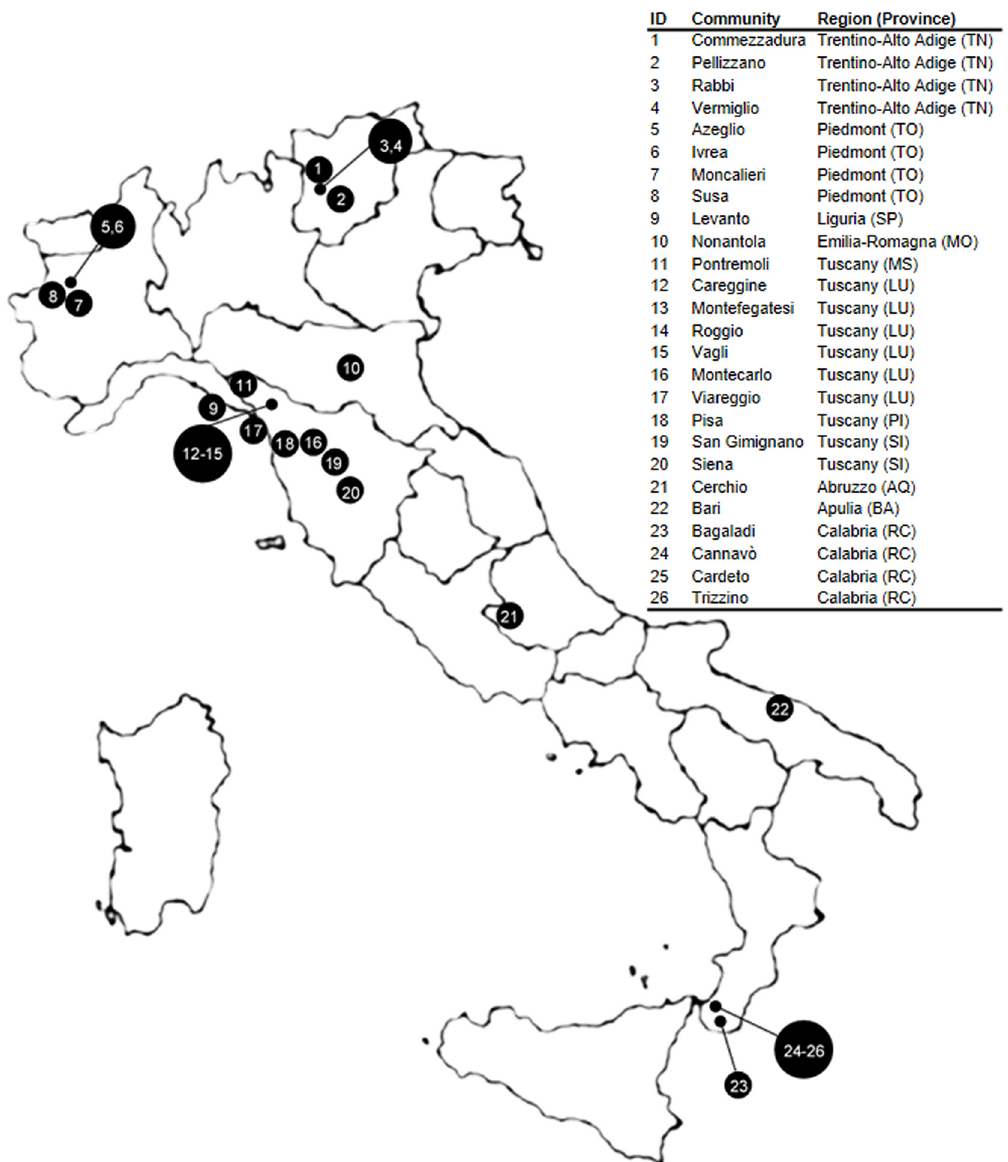
Fig 1. Map of Italy showing the location of the 26 investigated communities. This Fig is similar, although not identical, to the original image, and is therefore for illustrative purposes